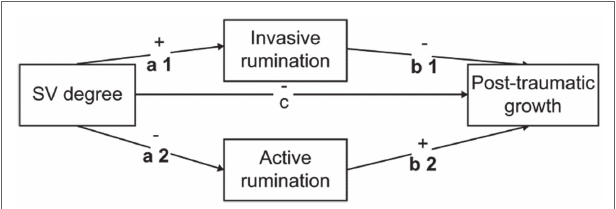
FIGURE 1 | Hypothetical model: active and invasive rumination as bi- meditating variables. a1 refers to the path coefficient of SV degree to invasive rumination, b1 refers to the path coefficient of invasive rumination to PTG when SV degree and passive rumination are put into the model at the same time. Similarly, a2 refers to the path coefficient of SV degree to active rumination, b2 refers to the path coefficient of active rumination to PTG when SV degree and active rumination are put into the model at the same time. c refers to the total effect of SV degree on